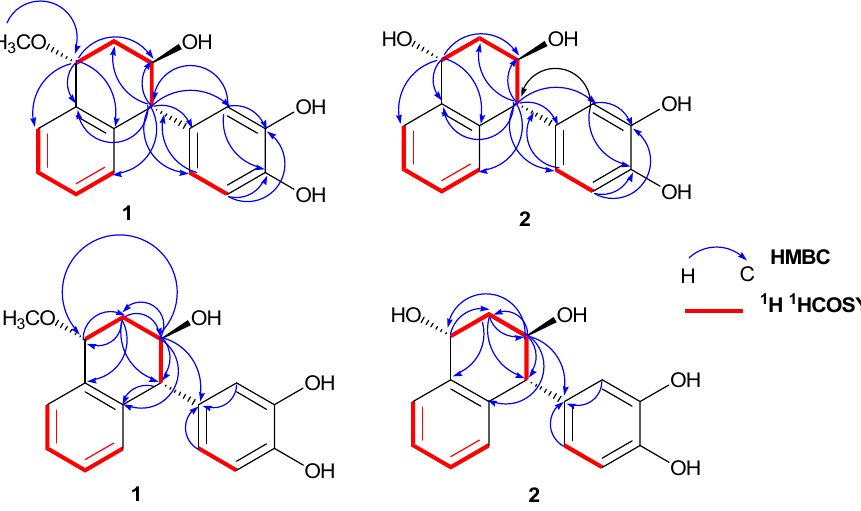
Figure 2. Key HMBC and 1 H 1 H-COSY correlations of 1 and 2